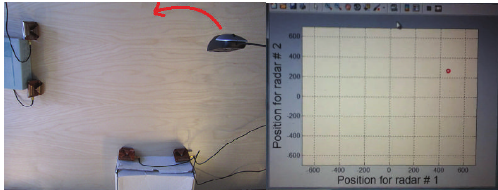
Figure 17: An orthogonal measurement setup for two-dimensional tracking (left) and the graphical user interface implemented in Matlab (right), where the red dot indicates the location of the target.